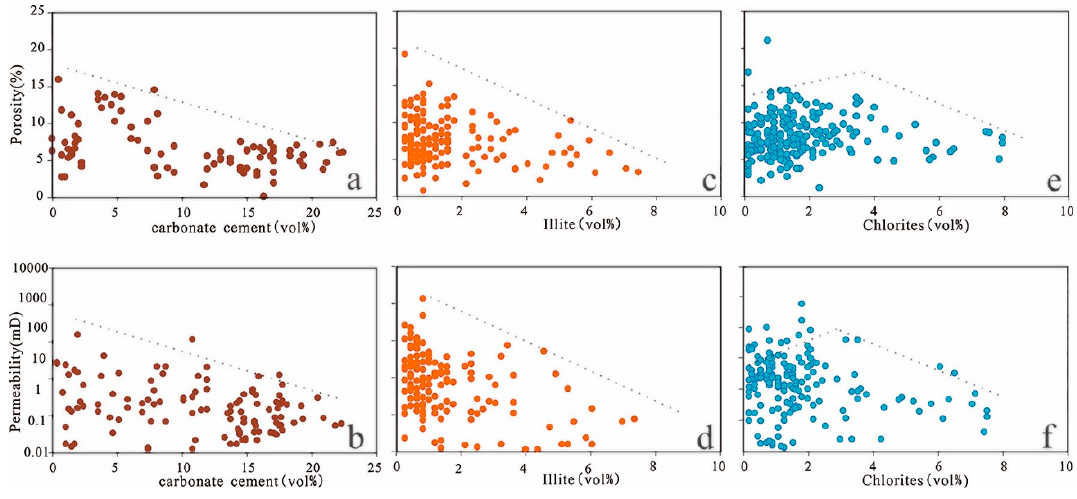
Figure 16. ( a ) Porosity versus carbonate cements. ( b ) Permeability versus carbonate cements. ( c ) Porosity versus illite cements. ( d ) Permeability versus illite cements. ( e ) Porosity versus chlorite cements. ( f )Permeability versus chlorite cements.